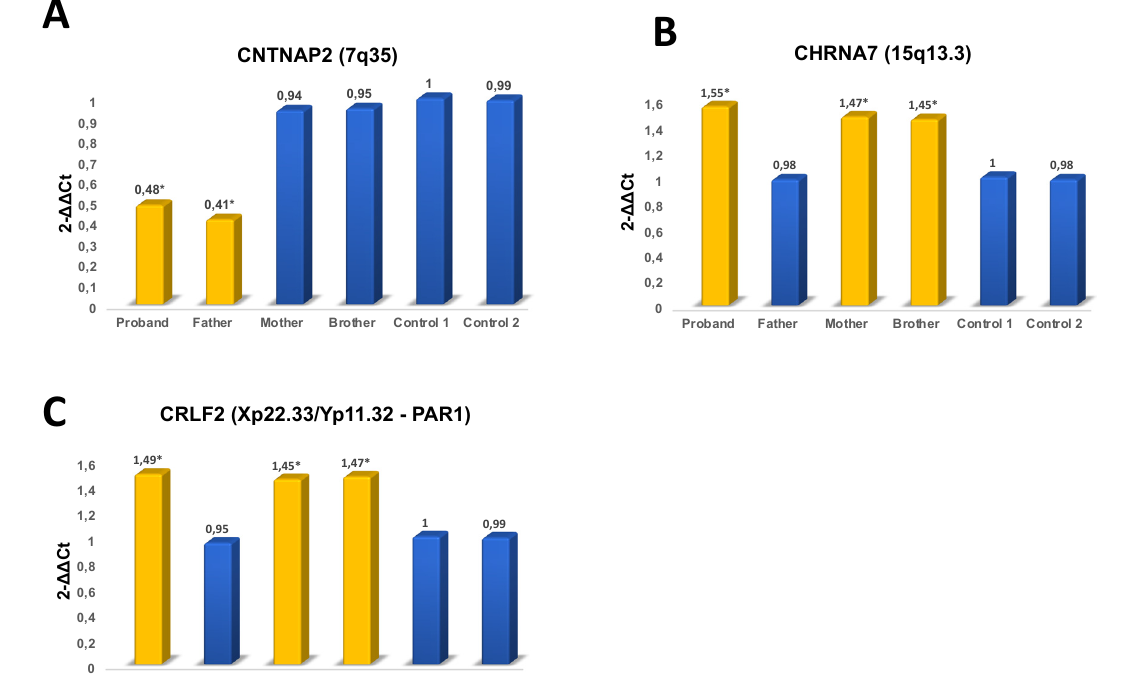
Figure 3. Sybr Green qPCR assay. ( A ) Paternal segregation of 7q35 microdeletion. ( B ) Maternal segregation of 15q13.3 and ( C ) PAR1 microduplications.